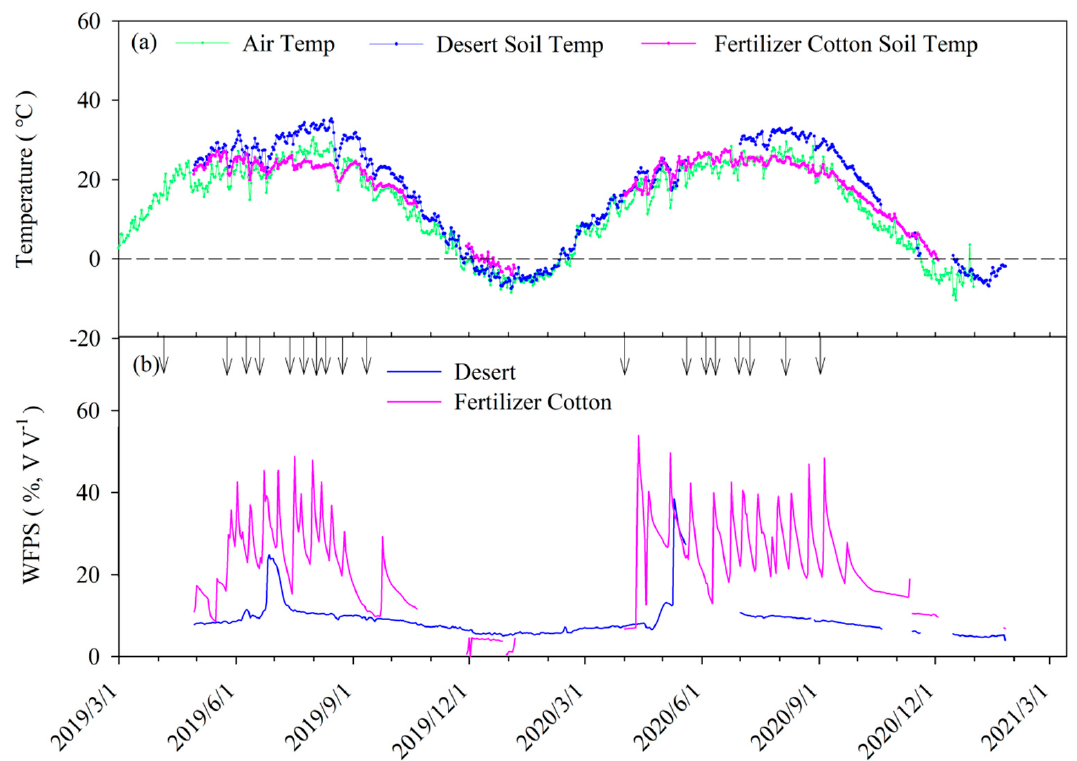
Figure 1. Air temperature and soil temperature ( a ) and water − filled pore space (WFPS) ( b ) at a 5 cm soil depth over the experimental period. Arrows indicate dates of irrigation.